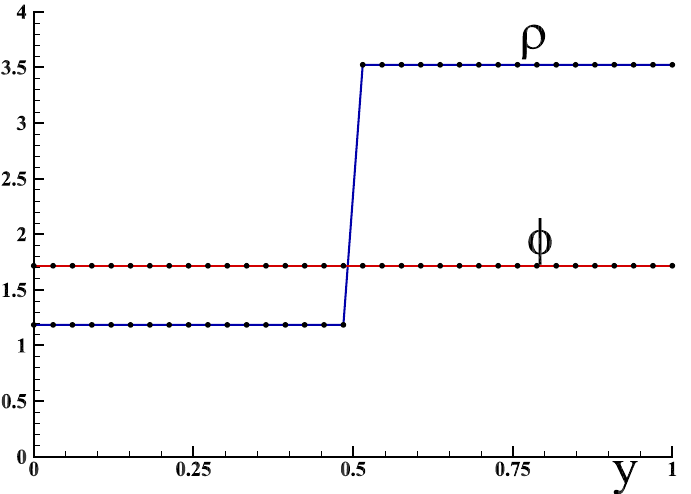
Figure 3. Evolutions of the density ρ and of the scalar potential 10 − 5 × φ as a function of the vertical coordinate y for a time t = 100 s and an injection velocity V 0 = − 0.01 m s − 1 for a mesh of 32 2